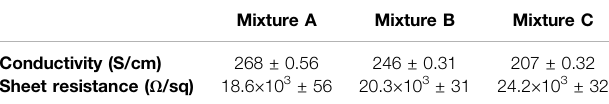
TABLE 3| Conductivitiesand sheet resistancesof fi lmsspincoatedfrom thethree different